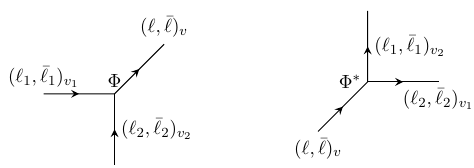
Figure 2 . Representation of the intertwiners (cid:8) and (cid:8) (cid:3) as generalized topological